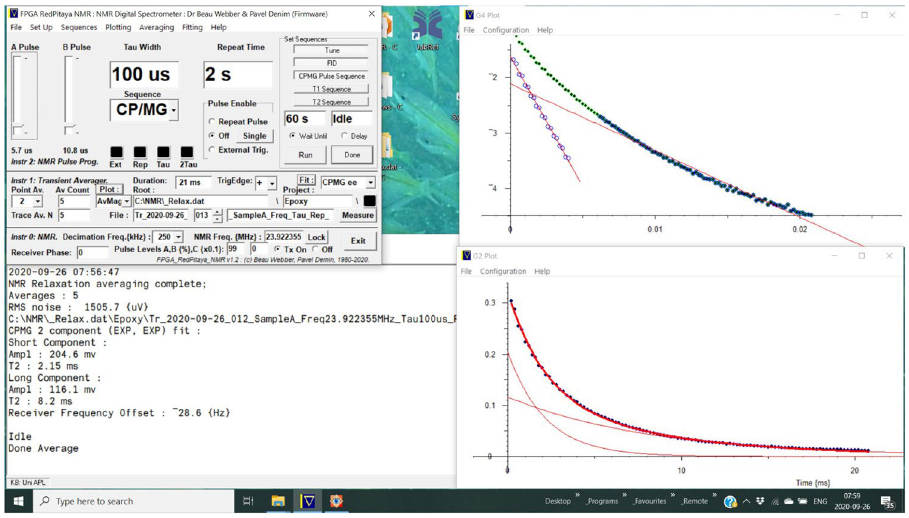
lin fit is performed (top right). Two straight-line fits extract initial parameters for a subsequent full non-linear double-exponential fit (bottom right). The fitted parameters are then shown (bottom left) and saved to file. Decay component amplitude ratios are affected by the crystalline/amorphous ratio in the polymer